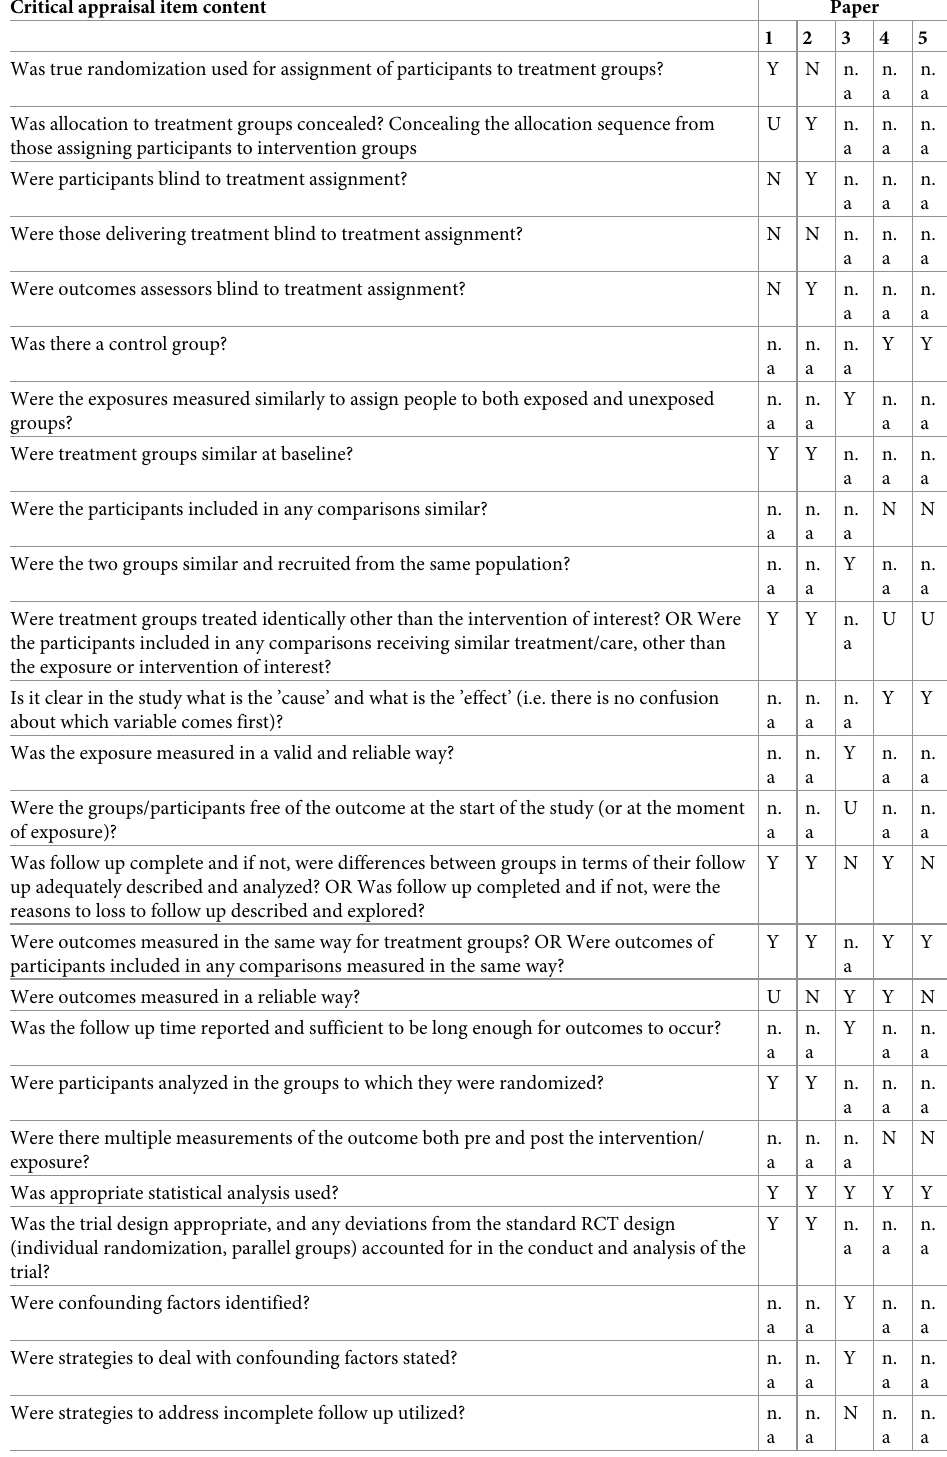
Table 1. JBI critical appraisal checklist for RCTs, quasi-RCTs and cohort